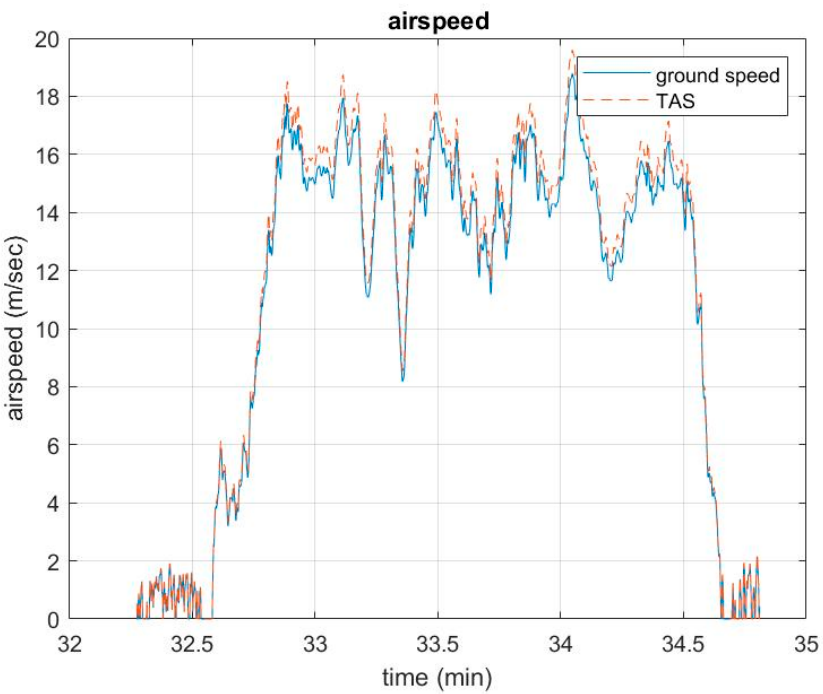
Figure 17. Airspeed in the second round of the second flight test (time = 32–35 s).